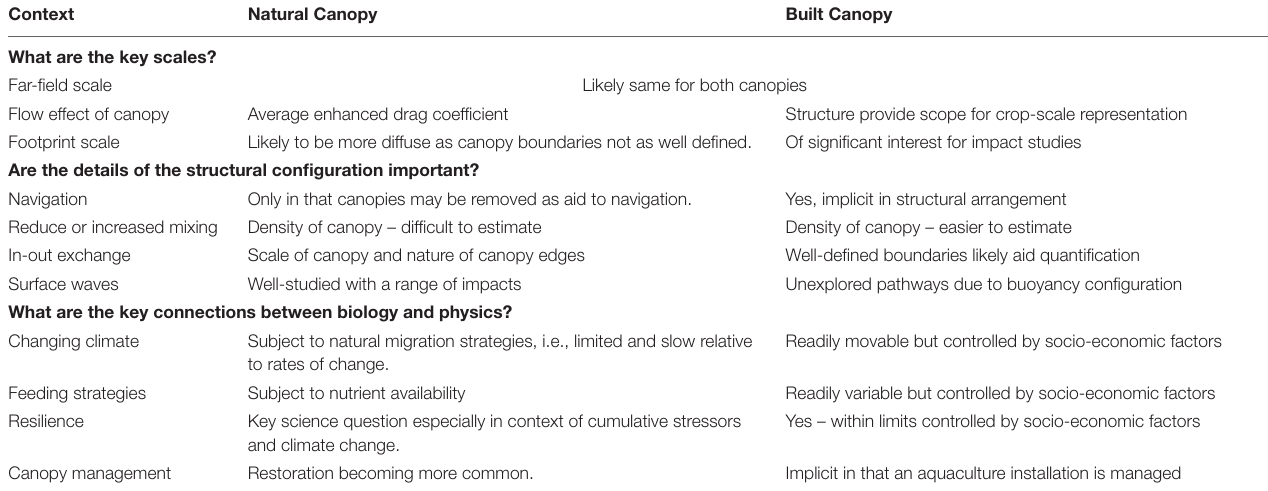
TABLE 1 | Comparison of key questions for built and natural canopy